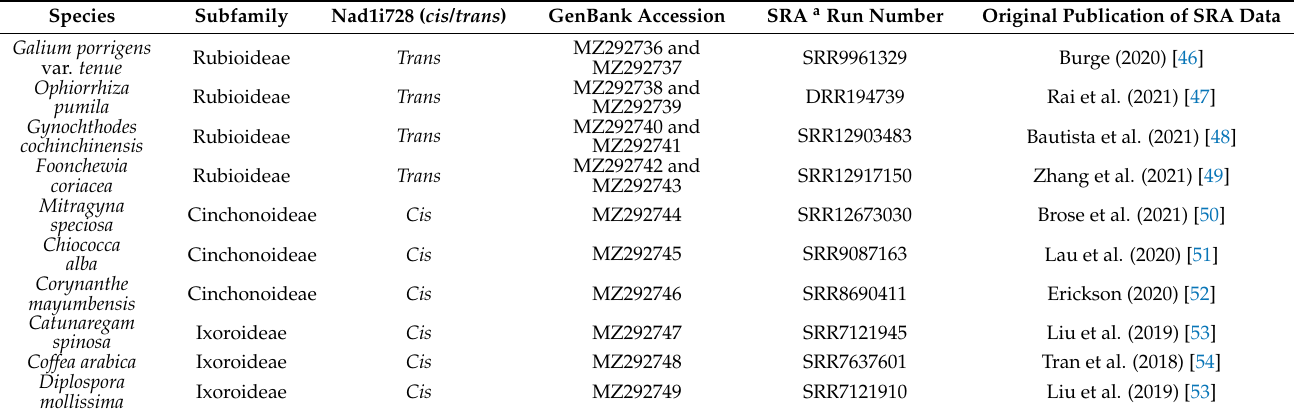
Table 4. The status of nad1i728 in ten representatives of three subfamilies in Rubiaceae.